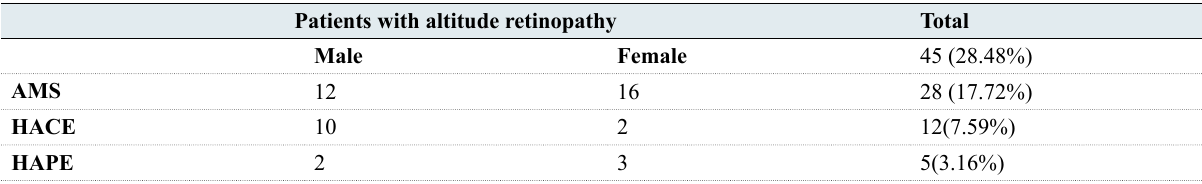
Table 2: Frequency of high altitude retinopathy in high altitude illness patients Patients with altitude retinopathy Total Male Female 45 (28.48%) AMS 12 16 28 (17.72%) 12(7.59%) 3 5(3.16%)